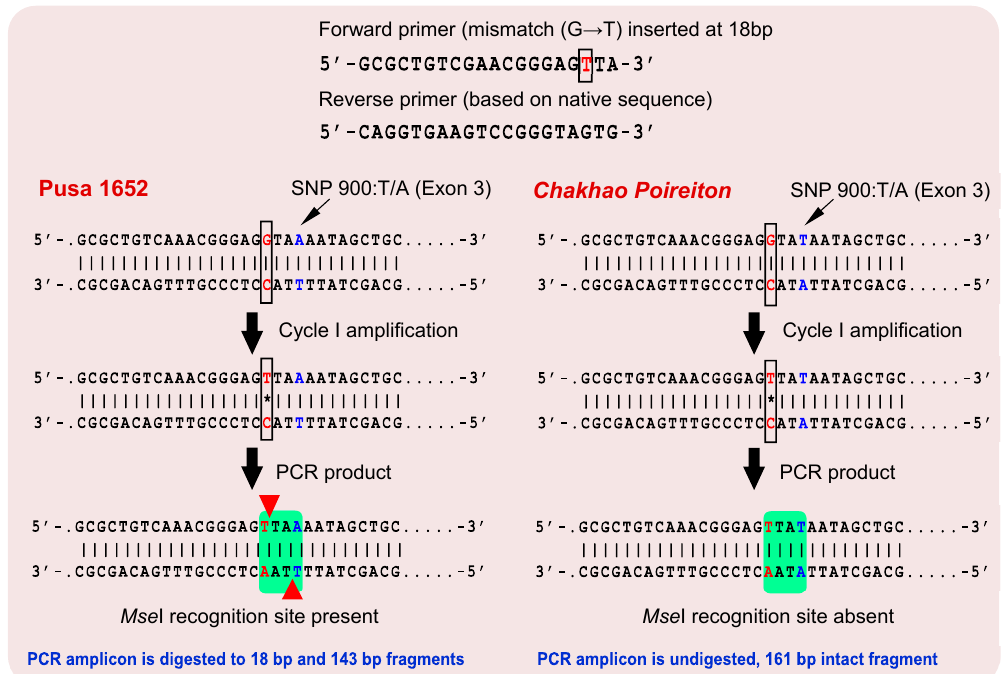
Figure 3. Development of derived cleaved amplified polymorphic sequence (dCAPS) marker, AKS-Sd1, and the validation of causal single-nucleotide polymorphism (SNP). (A) A restriction site for Mse I was generated, including SNP, which is cut by the enzyme producing cleaved products in Pusa 1652, while no cleaving occurs in Chakhao Poireiton .